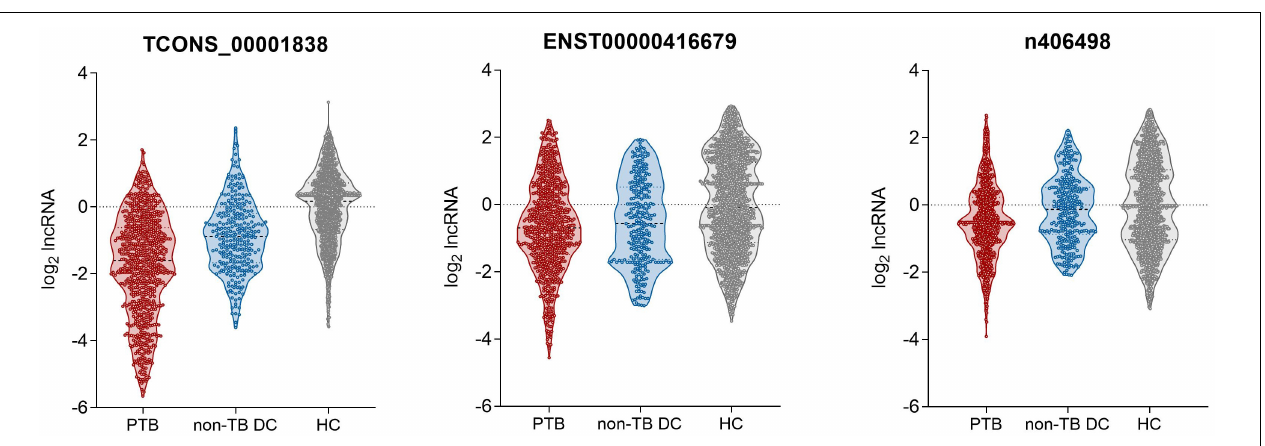
FIGURE 3 | Expression of candidate LncRNAs in selection